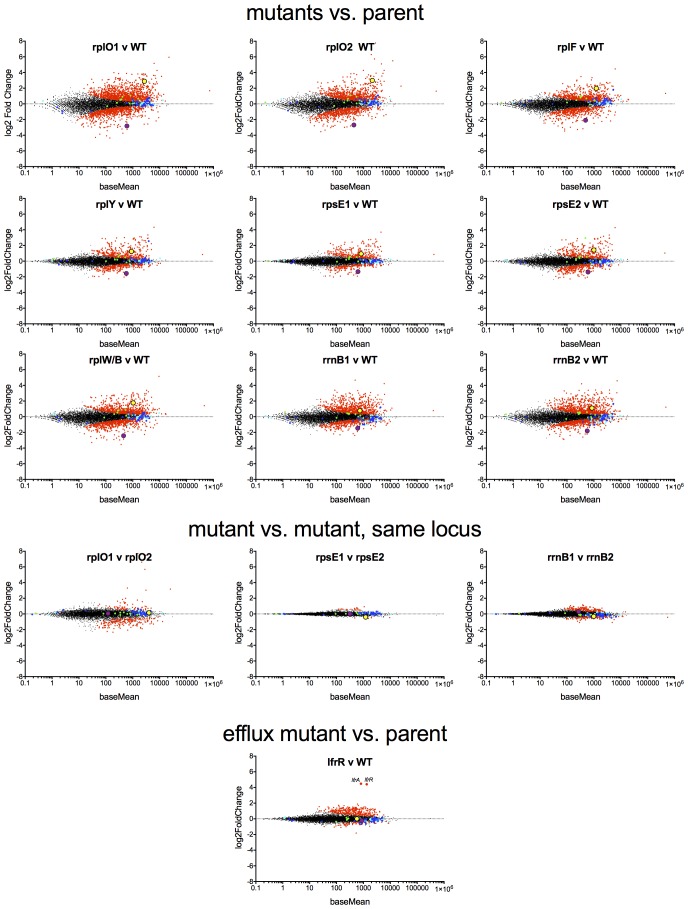
MA plots of the DESeq2 output relative to the parent for nine ribosomal mutants and lfrR mutant, highlighting whiB7 (yellow dot) and katG (purple dots).Components of the large ribosome are blue and small ribosome are green.